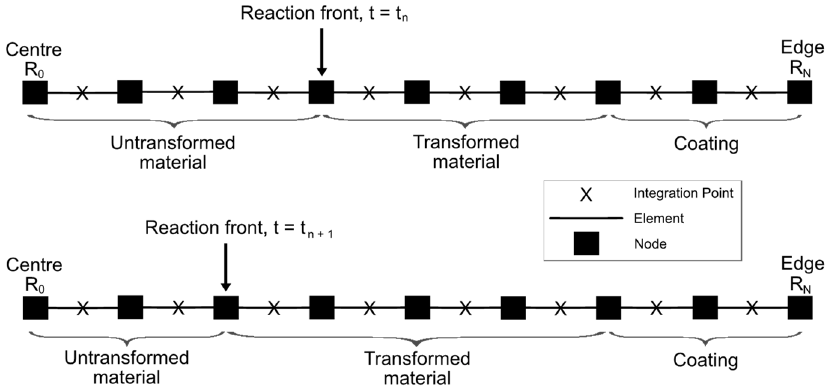
Figure 2. Schematic representation of the FE mesh and the reaction front movement from the edge ( R N ) of the particle to its centre ( R 0 ).